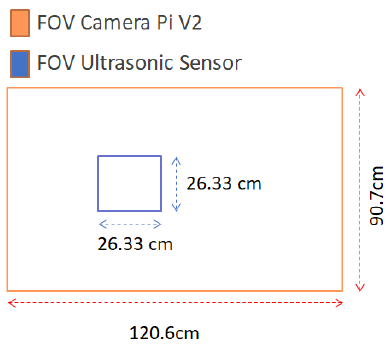
Figure 15. Field of view of both sensors.